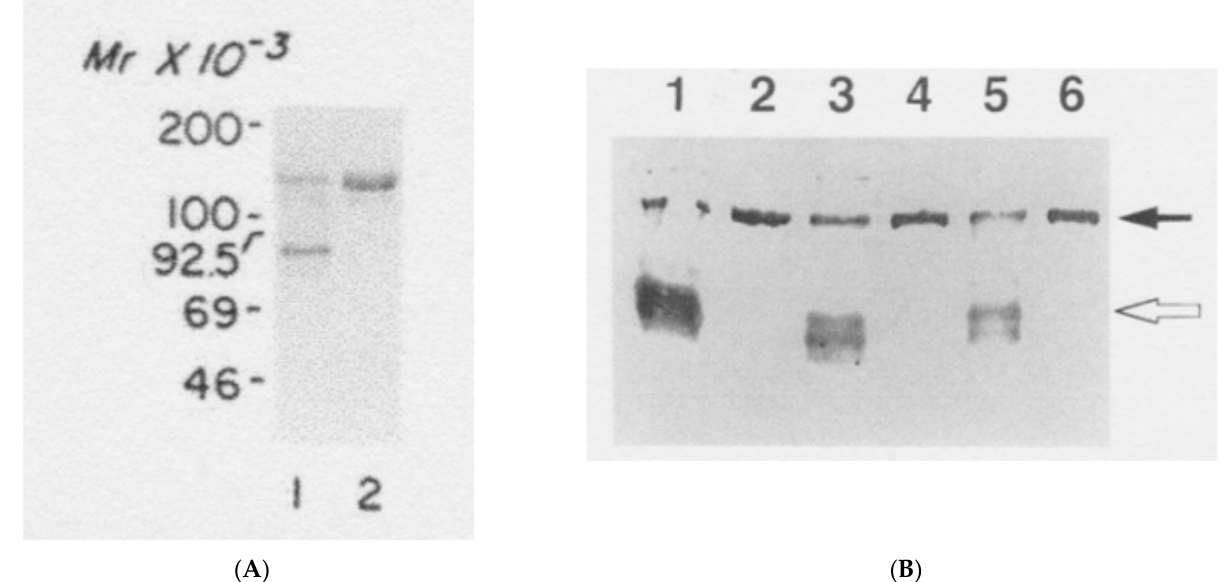
Figure 3. SDS ‐ PAGE of ceruloplasmins without and with heating in SDS ‐ sample buffer prior to electrophoresis, showing separation of two ceruloplasmin bands, when not heated. ( A ) Purified human ceruloplasmin, not heated (lane 1) or heated at 100 °C for 3 min (lane 2), prior to electrophoresis, and stained with Coomassie blue. Migration of molecular weight markers (Mr, in kDa) is also shown on the left. Reprinted with permission from Sato and Gitlin [26]. ( B ) Immunoblot of human ceruloplasmin isolated by immunoaffinity chromatography from secretions of cultured rat hepatic cells, where apo and holo forms were distinguished by not heating the samples prior to SDS ‐ PAGE (lanes 1, 3, 5), and compared with the results from preheating (lanes 2, 4, 6). The sources of the ceruloplasmins were secretions from long ‐ term cultured hepatocytes of Long ‐ Evans Agouti (LEA) and Long ‐ Evans Cinnamon (LEC) rats that had been transfected with human ceruloplasmin cDNA, and ceruloplasmins isolated and immunodetected used monoclonal antibody against human ceruloplasmin that did not react with rat ceruloplasmin. Reprinted with permission from Nakamura et al. [14]. The objective of the Nakamura studies was to determine how a lack of the ATP7B copper pump in LEC hepatocytes—compared to the normal LEA rats—would affect synthesis and the secretion of apo and holo ceruloplasmin produced by the human gene transfected into these cells.